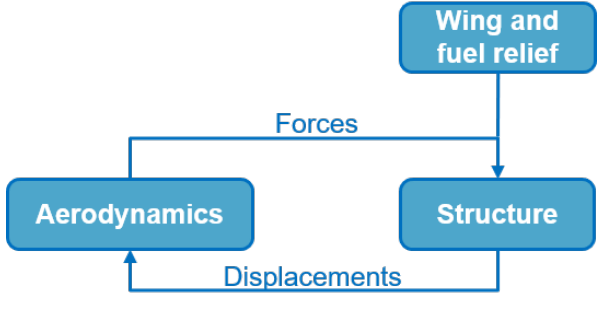
Figure 5. Static aeroelastic